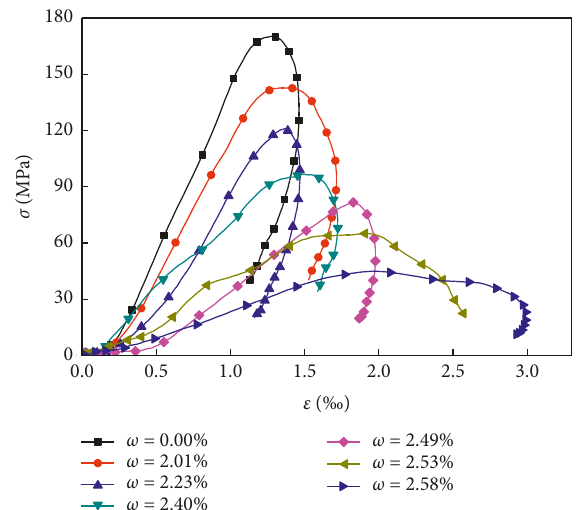
Figure 5: Stress-strain curve of sandstone with different moisture